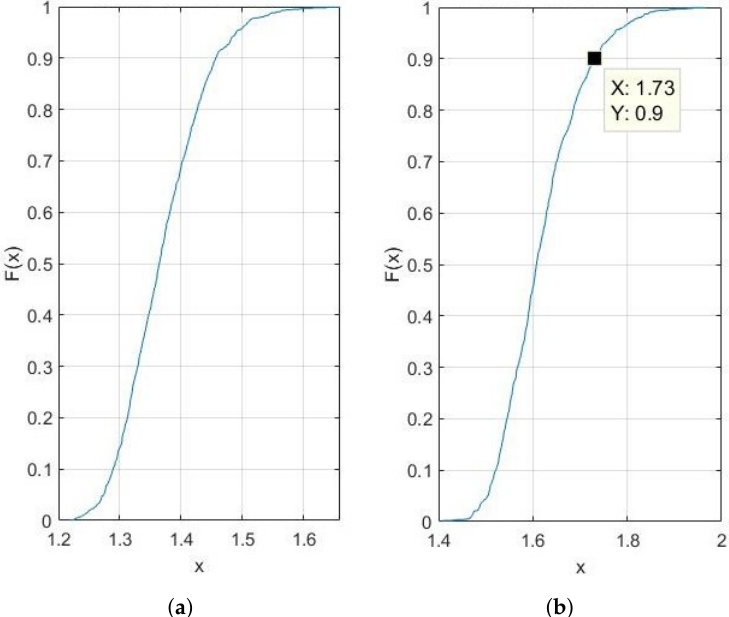
Figure A1. ( a ) Empirical CDF for T = 1 s. ( b ) Empirical CDF for T = 10